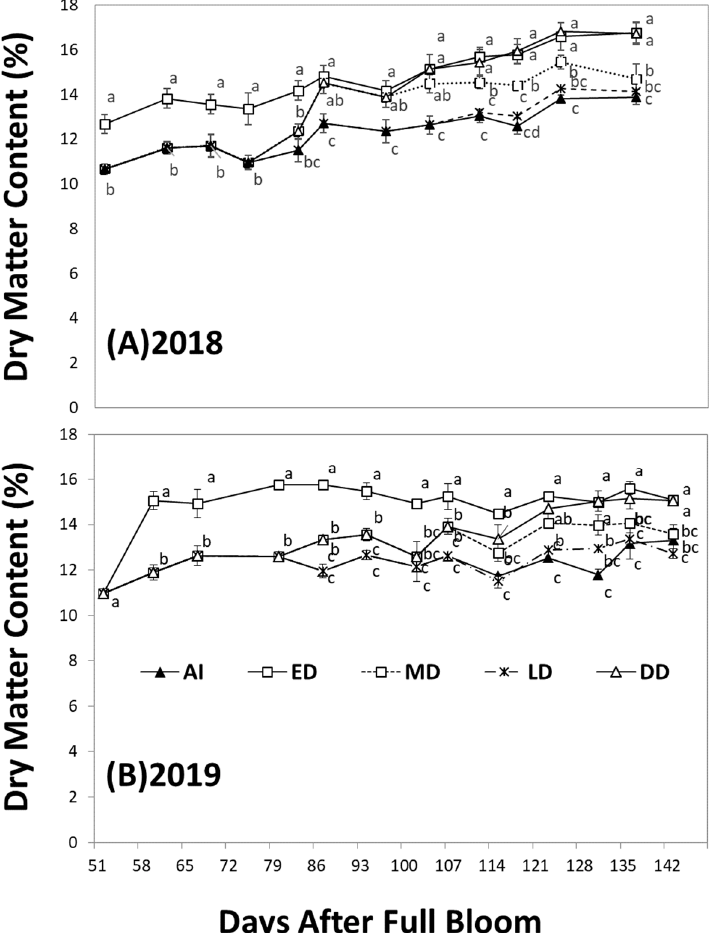
Figure 3. Effect of different irrigations on the seasonal changes of the DMC follow-up treatment in Ambrosia™ apples measured with an F-750 NIR spectrometric device in a conventional orchard in 2018 ( A ) and 2019 ( B ), respectively. The points are LS means ± the standard error of the mean. Means with different letters in a date are pairwise significant ( p ≤ 0.05) differences. AI = adequate irrigation; ED = early-summer deficit irrigation (DI); MD = middle-summer DI; LD = late-summer DI; DD = double-period DI.